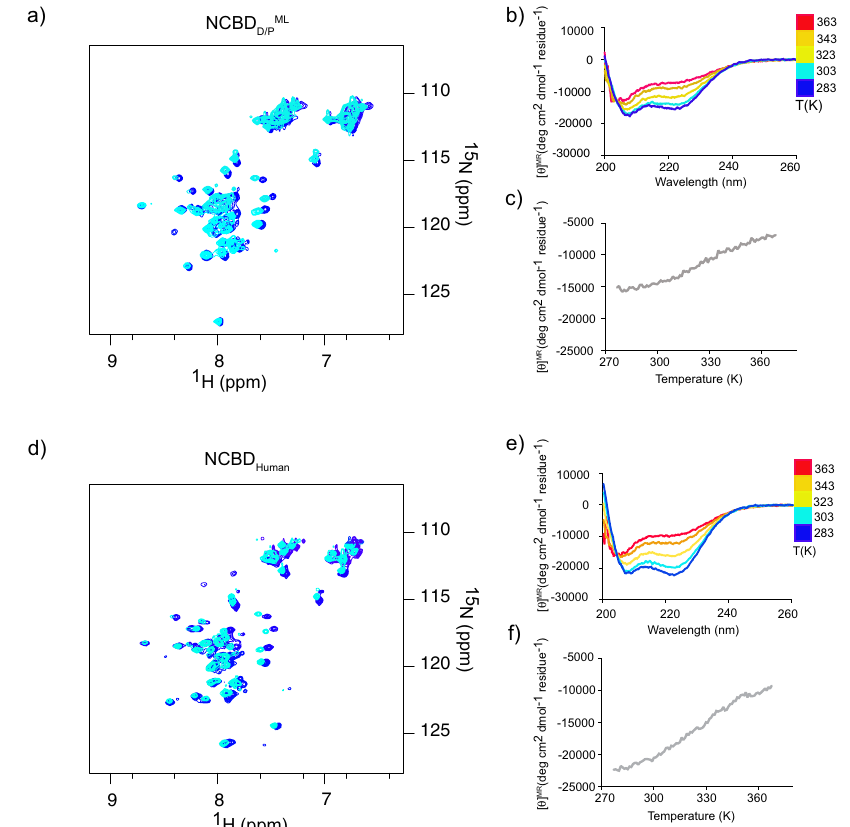
Fig. 5 Temperature dependence for ancestral NCBD D/P ML and extant NCBD Human . a Overlay of 1 H- 15 N HSQC spectra of NCBD D/P ML at 283 K (blue) and at 303 K (cyan). b Circular dichroism spectra at a range of temperatures (283 – 363 K) for NCBD D/P ML . c Molecular ellipticity at 222 nm (probing α -helix content) as a function of temperature for NCBD D/P ML . All experiments in ( a – c ) were performed at pH 2.4. d – f Similar experiments as in panels ( a – c ), respectively, for NCBD Human performed at pH